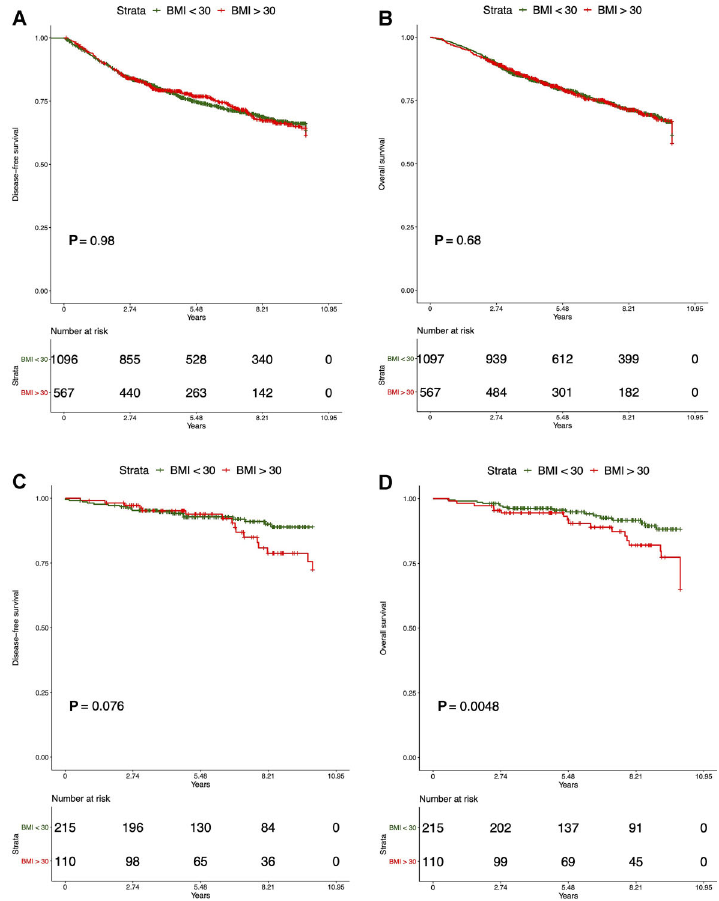
Figure 2. Survival analysis of stage I to III breast cancer patients, according to the body mass index (BMI). A , Disease-free survival in all patients; B , overall survival in all patients; C , disease-free survival in stage I patients at diagnosis; D , overall survival in stage I patients at diagnosis.